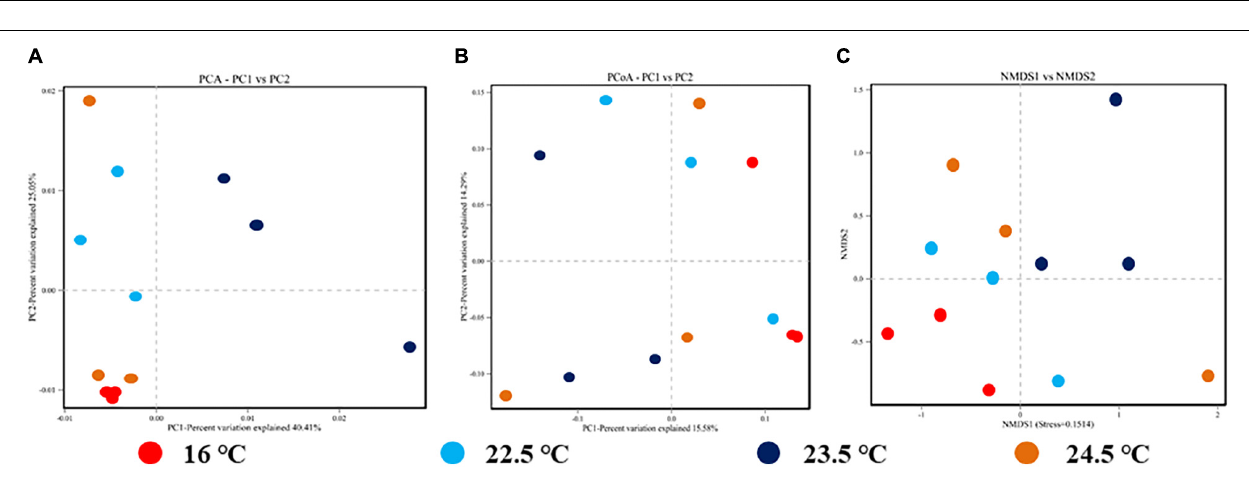
Frontiers in Microbiology |